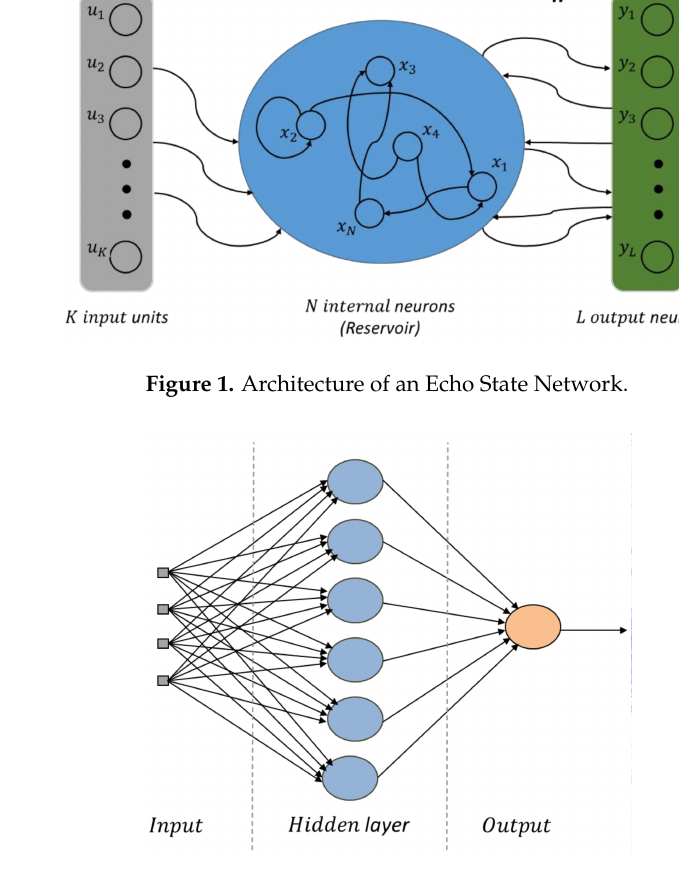
Figure 2. Architecture of a Multilayer Feedforward